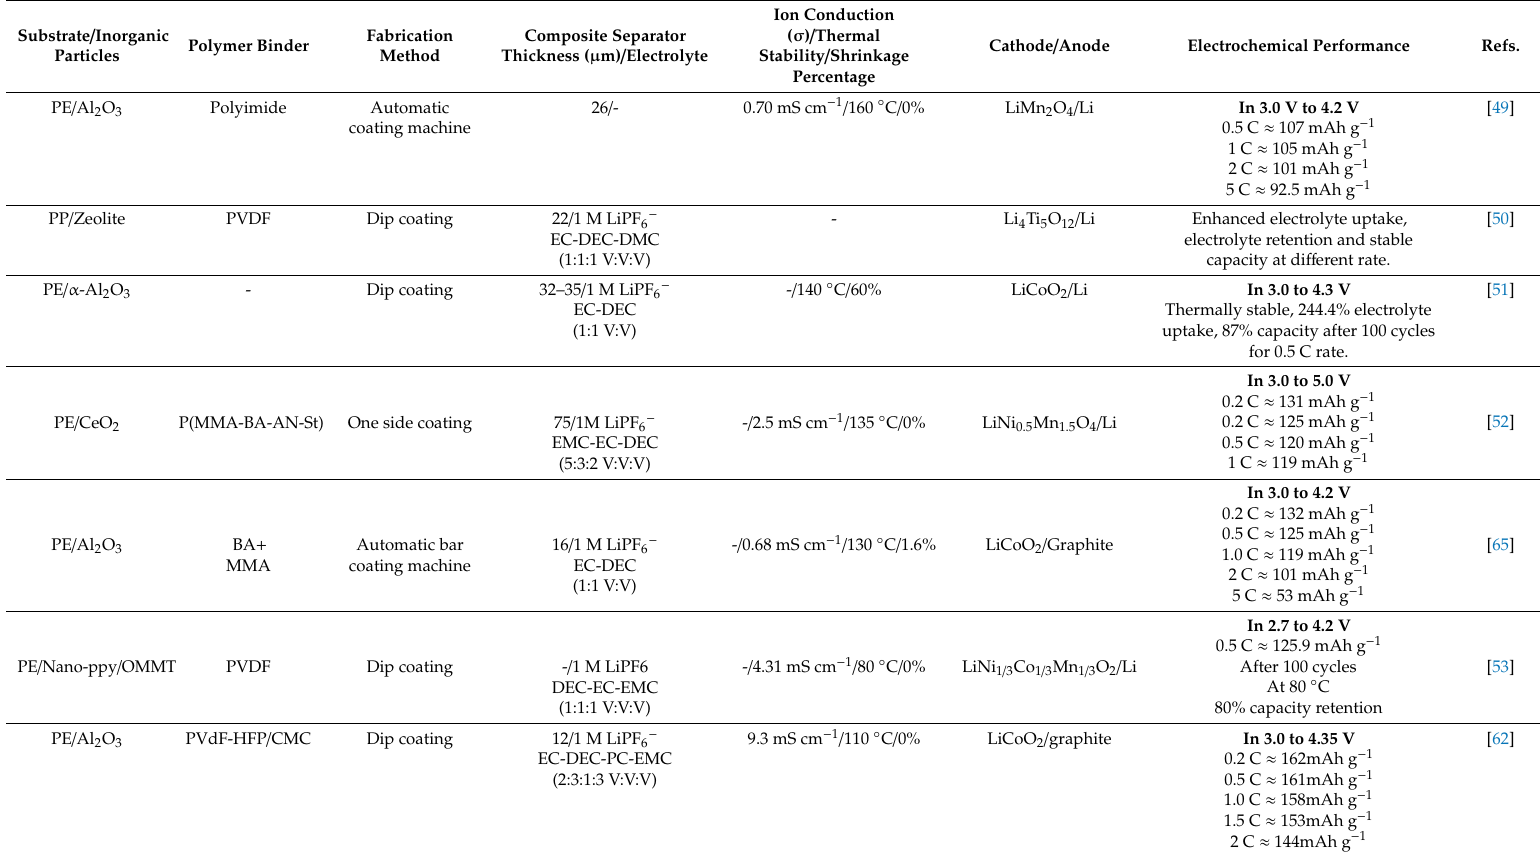
Table 1. Additional information’s about composite